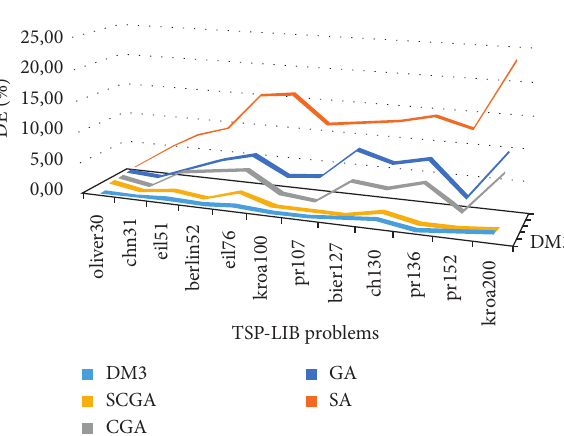
Figure 11: Trend of the metaheuristic DM3 when the number of nodes increases.